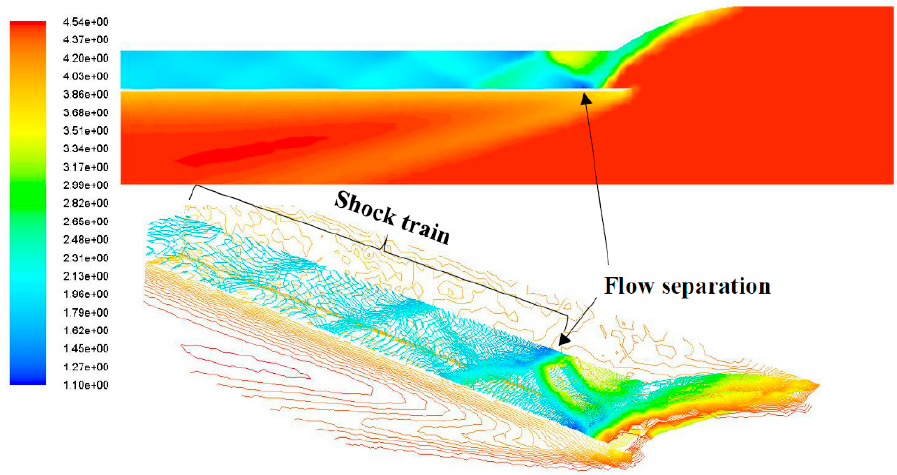
Figure 29. CFD results for 3-D inlet simulation at Mach 4.5.